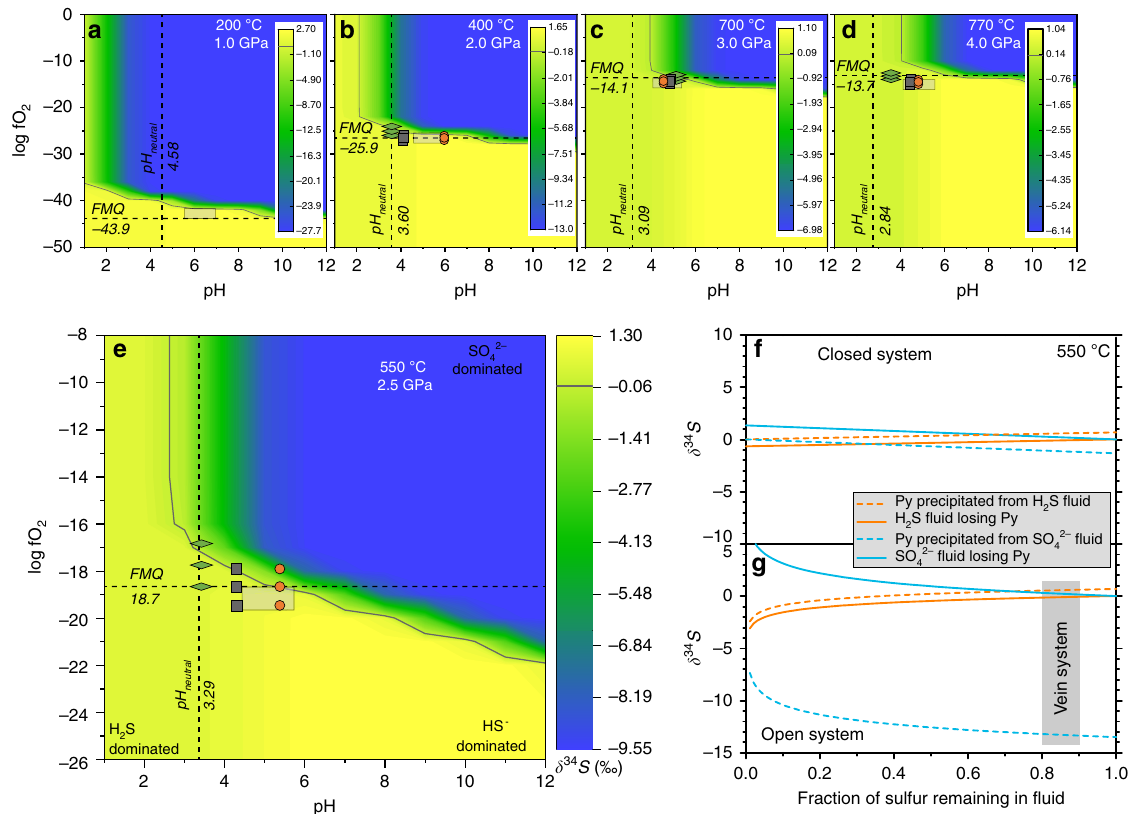
Fig. 7 Thermodynamic modelling of sulfur isotope fractionation as a function of temperature, f O 2 and pH. a – d In fl uence of f O 2 and pH on the isotopic compositions of pyrite precipitated from hydrothermal fl uids at ionic strength I = 1.0 and δ 34 S ∑ S = 0 ‰ , at speci fi c P – T conditions of various depths along the subduction interface. The squares (metasediment), circles (metabasalt) and diamonds (serpentinite) represent estimated f O 2 conditions (Supplementary Note 1) and calculated pH values from the DEW model. The rectangles denote slab f O 2 – pH conditions from ref. 43 . The color scales ( ‰ ) refer to δ 34 S contours as a function of f O 2 and pH, and the gray solid line indicates the contour with no sulfur isotope fractionation. e , δ 34 S fractionation modelling at P – T conditions of the vein samples studied here. f – g Sulfur fractionation calculation plots of FeS 2 precipitation from fl uids at 550 °C in a closed system ( f ) and an open system following a Rayleigh fractionation model ( g ). Solid lines denote the fl uid phase, whereas the dashed lines represent the precipitated phase. The orange and blue lines represent the results for H 2 S- and SO 4 2 − - fl uids, respectively. Initial δ 34 S fl uid is 0 ‰ . The shaded area indicates the expected sulfur fraction of sul fi de precipitation under a channelized fl uid fl ux. Source data are provided in Supplementary